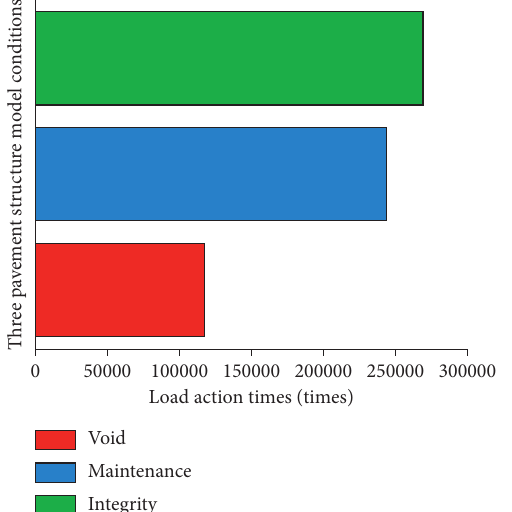
Figure 23: Compression fatigue failure load action times of three pavement structure models.